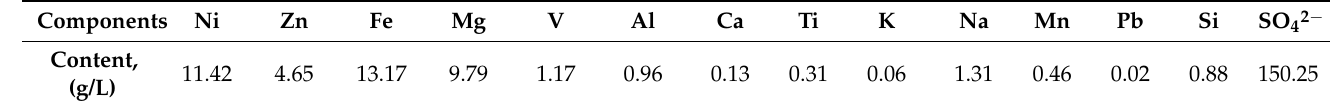
Table 3. Chemical composition of the leachate (g · L − 1